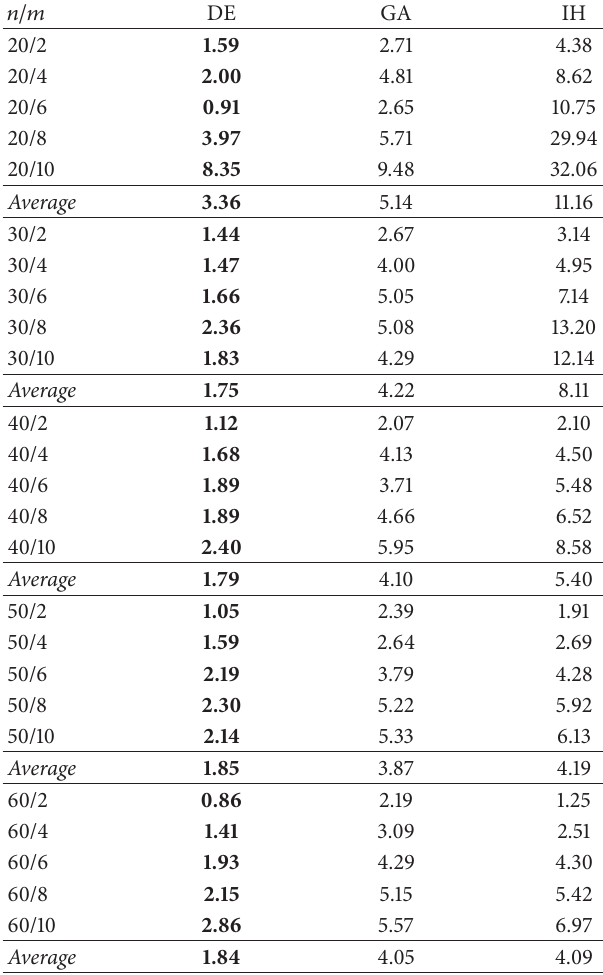
Table 4: Mean percent deviation for large size